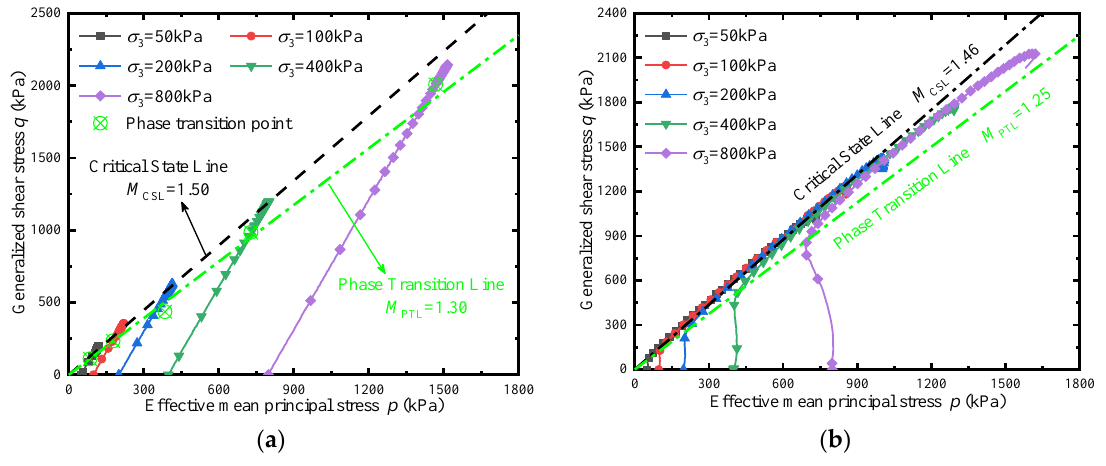
Figure 11. Effective stress path for drained and undrained test. ( a ) Effective stress path for drained test. ( b ) Effective stress path for undrained test.